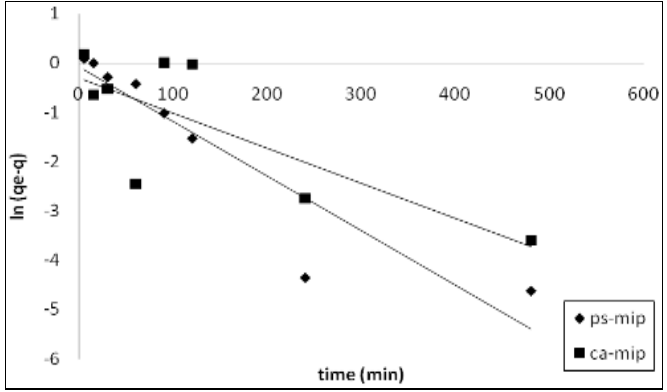
Figure 8. The first-order kinetic plots for the sorption of 2,4-DNP by CA-MIP and PS-MIP.